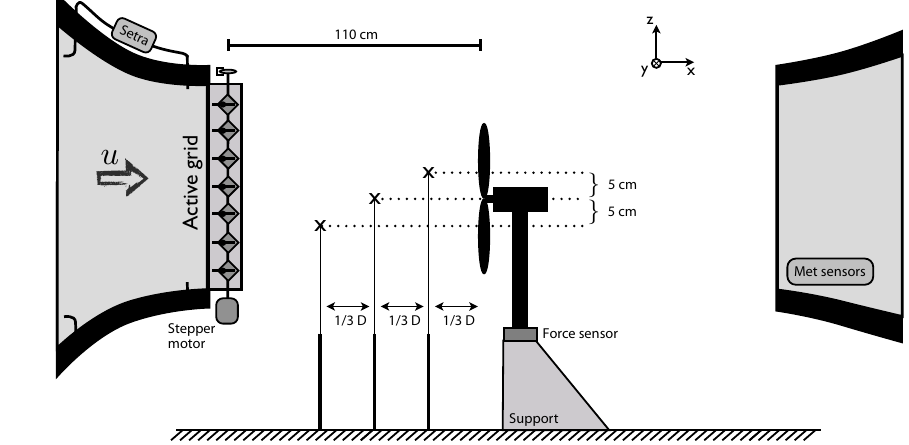
Figure 2. Schematic drawing of the experimental setup, side view. Scales do not match, D = 0 .